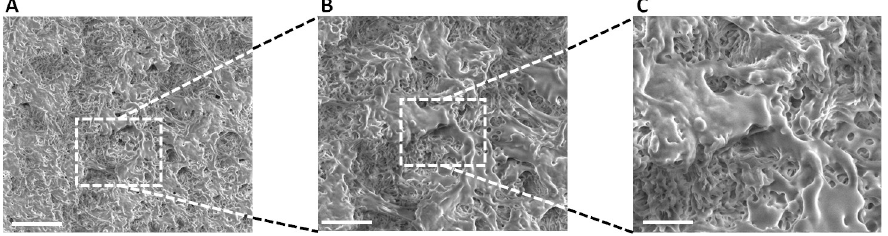
Fig 2. FE-SEM images from PLC films cross section. Inner structure of the PLC organogel film obtained by electrospraying, from A) 5000, B) 6000 and C) 12000 augments. (Scale bars corresponds to 20, 10 and 5 microns for A, B and C,